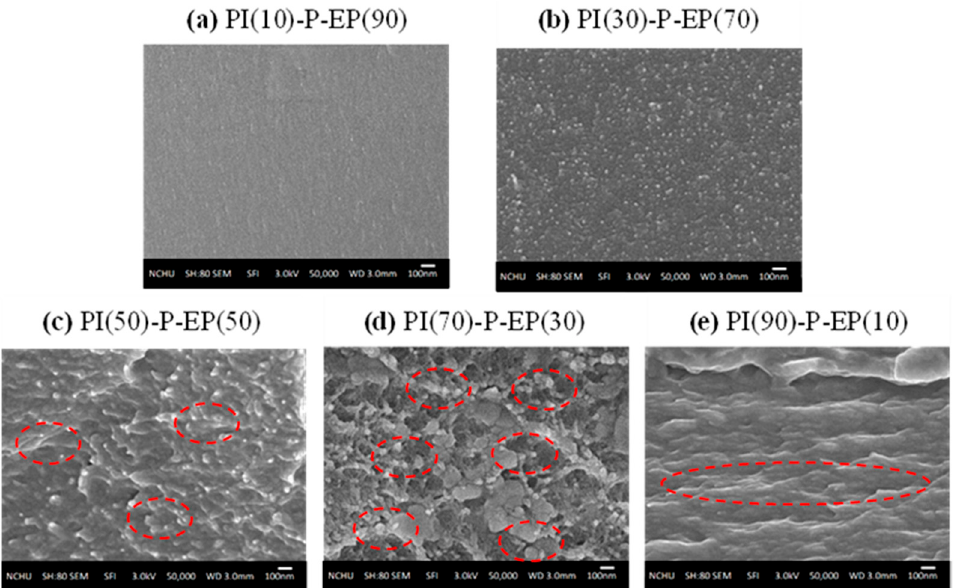
Figure 7. SEM of PI-P-EP (numbers in parenthesis are weight%); red circles mark typical microphase separation.